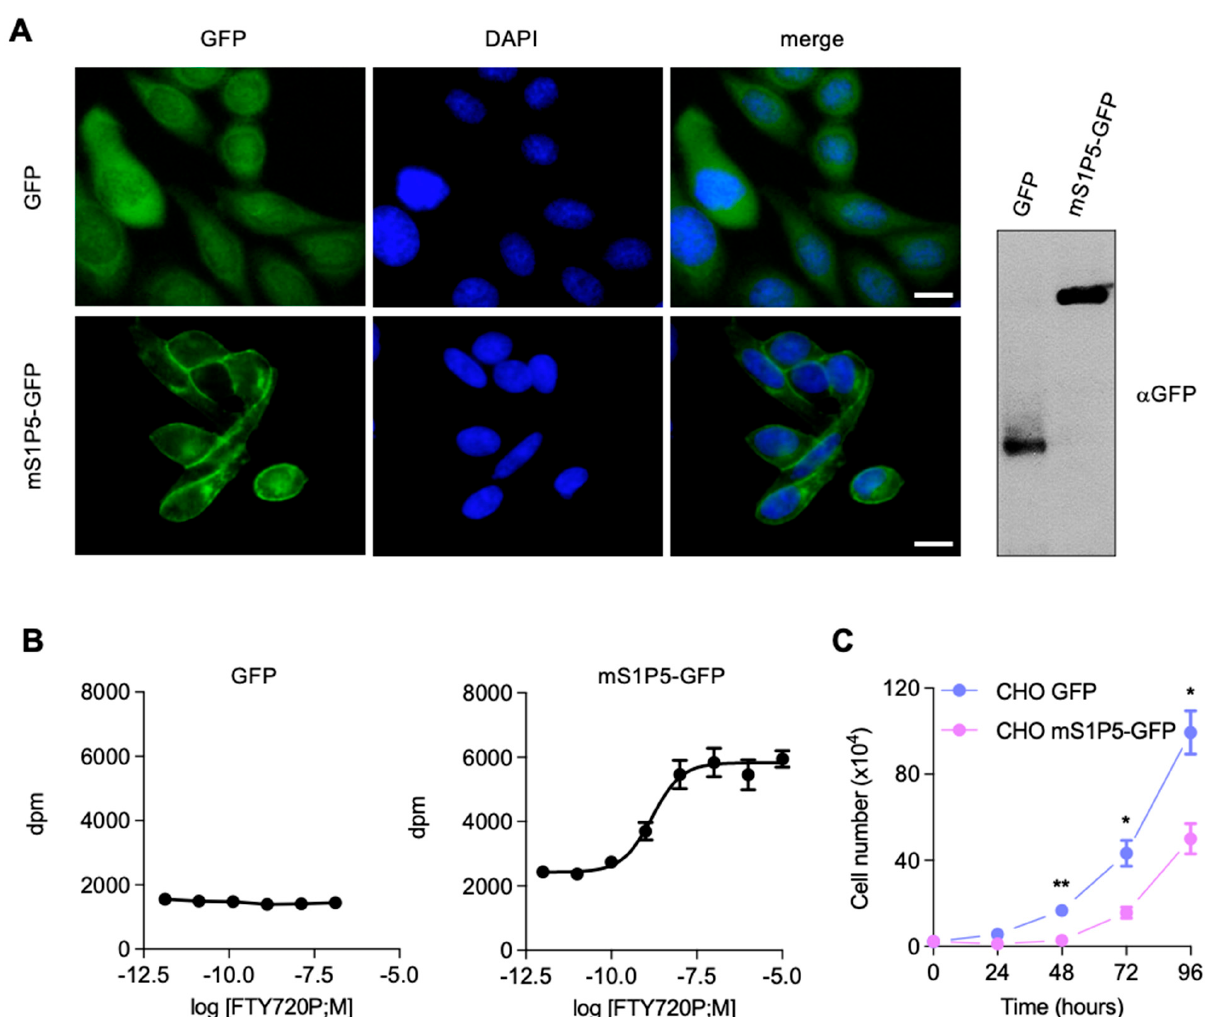
Figure 5. S1P5 induces growth arrest. ( A ), representative images showing CHO cells stably expressing GFP or mS1P5-GFP and stained for DNA with DAPI. Scale bar: 10 µ m. Right panel shows GFP and mS1P5-GFP levels in CHO cells analyzed by Western blot using antibodies against GFP. ( B ), pharmacological characterization of mS1P5R-GFP. Agonist stimulation of CHO cells ectopically expressing mS1P5-GFP or GFP alone. Membrane fractions were isolated and stimulated with increased concentrations of S1P or FTY720-P. The graph is representative of two independent experiments performed in duplicate. ( C ), growth properties of CHO cells stably expressing mS1P5R-GFP or GFP. CHO mS1P5-GFP or CHO GFP cells were plated at equal cell number and the cell number was counted daily over a period of four days. Growth curves show means ± SEM from three independent experiments performed in triplicates (**, p < 0.0021; *, p < 0.0134; *, p < 0.0157).